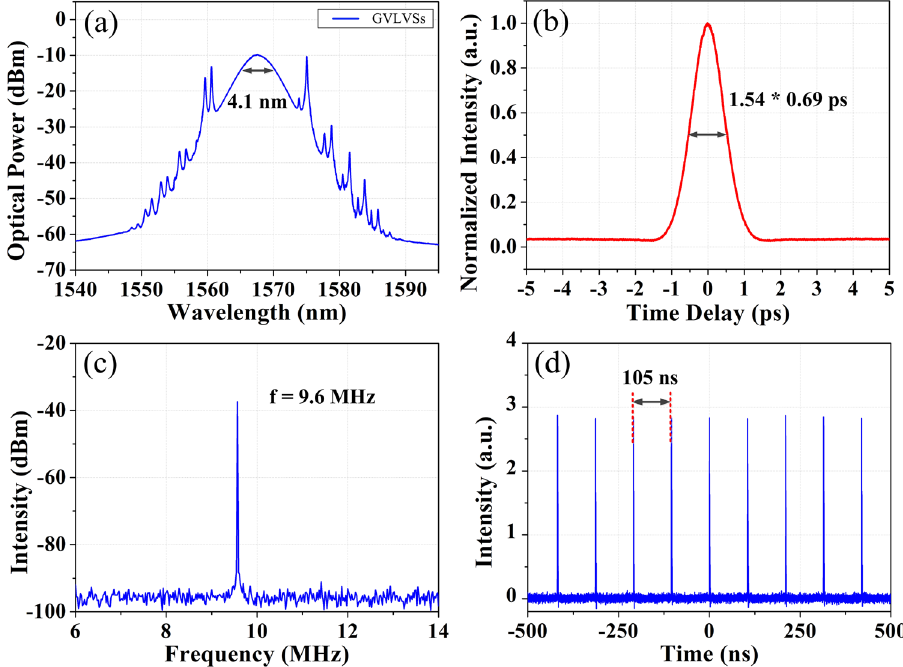
Figure 2. Group-velocity-locked vector solitons. ( a ) Optical spectrum, ( b ) autocorrelation trace, ( c ) RF spectrum and ( d ) fundamental mode-locked oscilloscope trace of the GVLVSs.